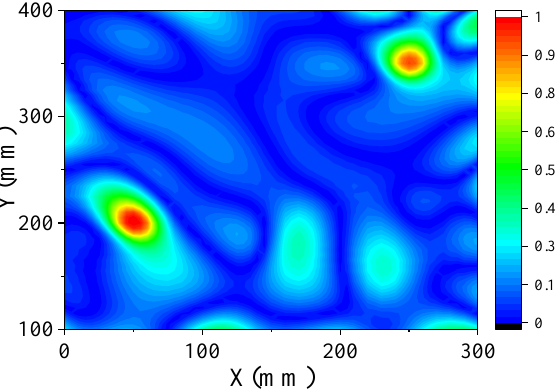
Figure 9. Imaging results of center frequency for double PIM sources.